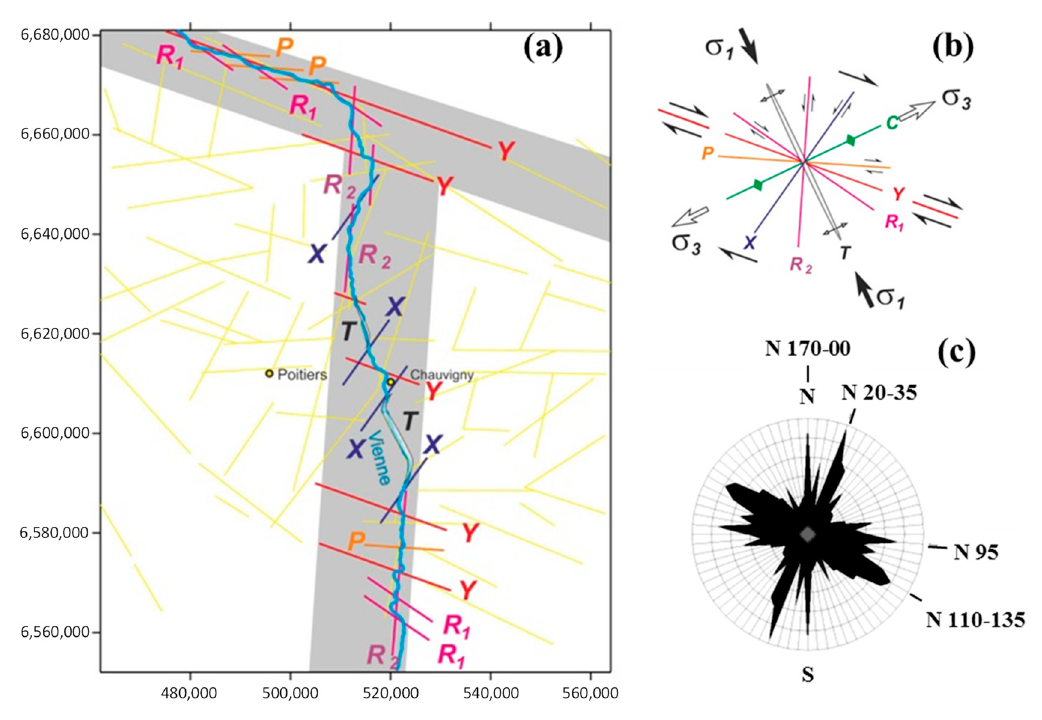
Figure 7. ( a ) Representation of major and minor trends of the Vienne River valley (shown by the blue line) derived from topography DEM as a combination of 105–110 ◦ , trending master shears Y, complimentary shears of R 1 (azimuth 120–125 ◦ ), P (azimuth 90–95 ◦ ), R 2 (azimuth 0–5 ◦ ), X (azimuth 30–35 ◦ ) types, and 150–155 ◦ , trending extensional joints T in a lazy S-shape. We inferred from the analysis of drainage patterns in the Vienne Department the azimuth of σ 1 , the maximum principal stress in the strike-slip regime, is about N150–155 ◦ E. Yellow dashed lines represent morpholineaments extracted from the shaded-relief elevation visualization model (Figure 6b). Grey zones correspond to two major directional clusters of the Vienne River valley represented by the master Y shears and secondary antithetic R 2 shears. ( b ) Fractures orientation from this study. ( c ) Fractures identification from the Poitou threshold [43].